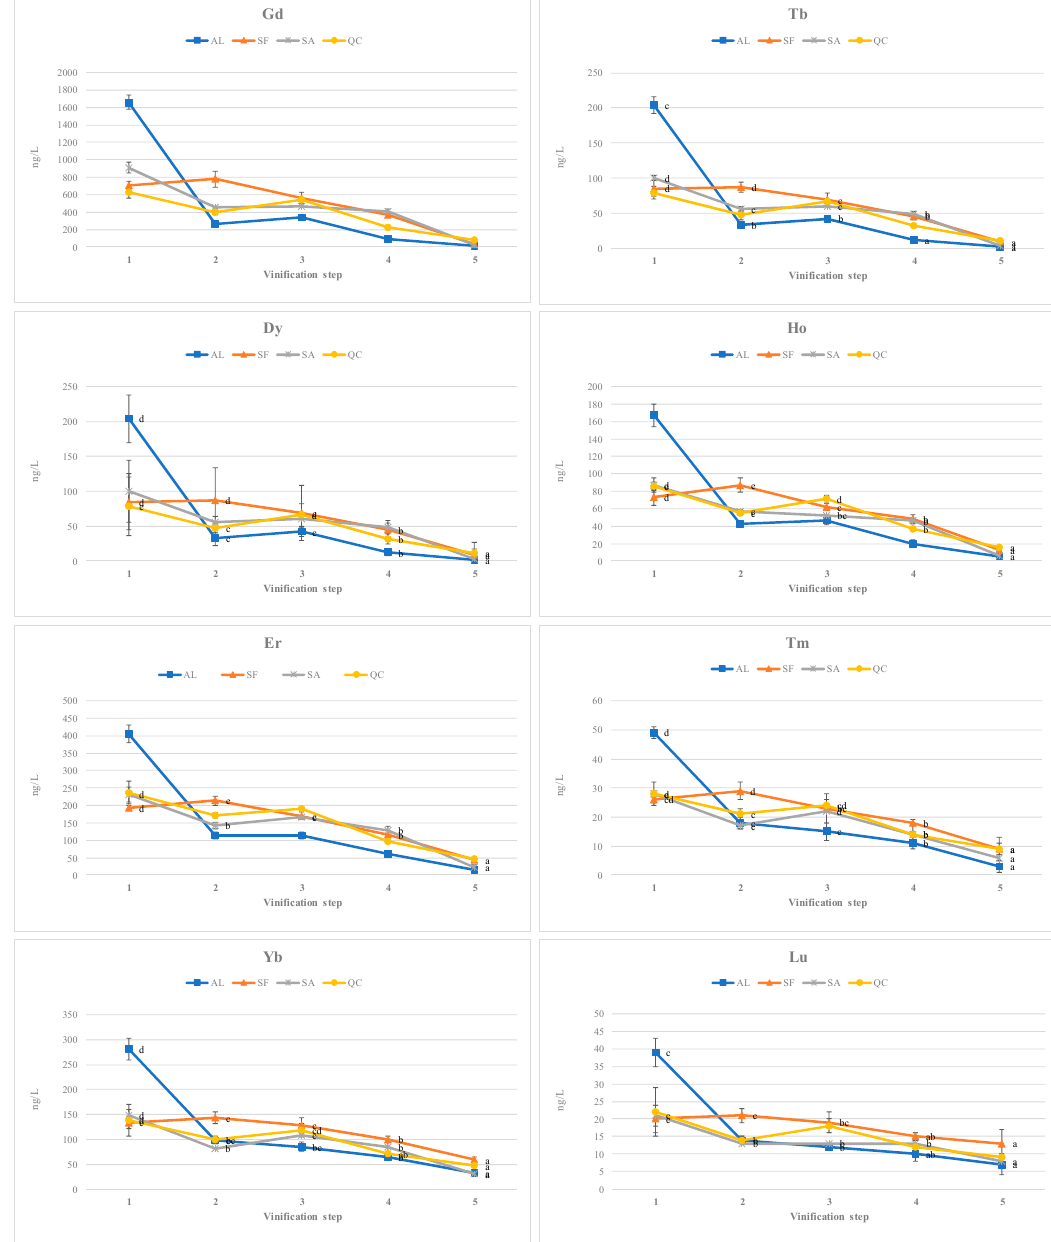
Figure 6. Evolution of rare earth elements concentrations over vinification, by vineyard of origin. (AL) Vinha de Algeruz; (SF) Quinta de S. Francisco; (SA) Quinta do Sanguinhal; (QC) Quinta dos Carvalhais. Vinification step: (1) after crushing and vatting; (2) after must corrections and inoculation; (3) during the alcoholic fermentation (density approximately of 1030 g/L); (4) after running off; (5) after malolactic fermentation and first racking, before any blending to preserve the trace to the vineyard of origin. For each element and vineyard, results correspond to mean values (and corresponding standard deviations) of three replicates and corresponding analytical duplicates ( n = 6). Means followed by the same letter are not significantly different at 0.05 level of significance. Values not followed by significance letters indicate that a non-parametric parametric test (Kruskal-Wallis test) was applied and comparison of means was not carried out.